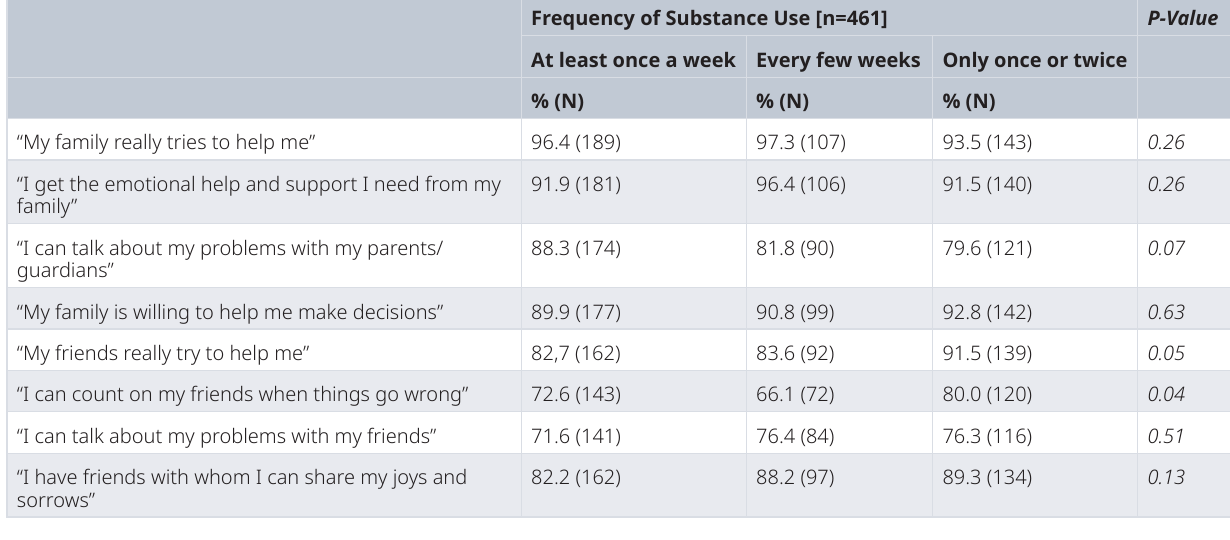
Table 7. Unadjusted regression analysis for frequency of substance use [RC: At least once per week]. At Least Once Every Only Once or Twice Few Weeks Relative Risk Ratio [CI] Relative Risk Ratio [CI] P-Value